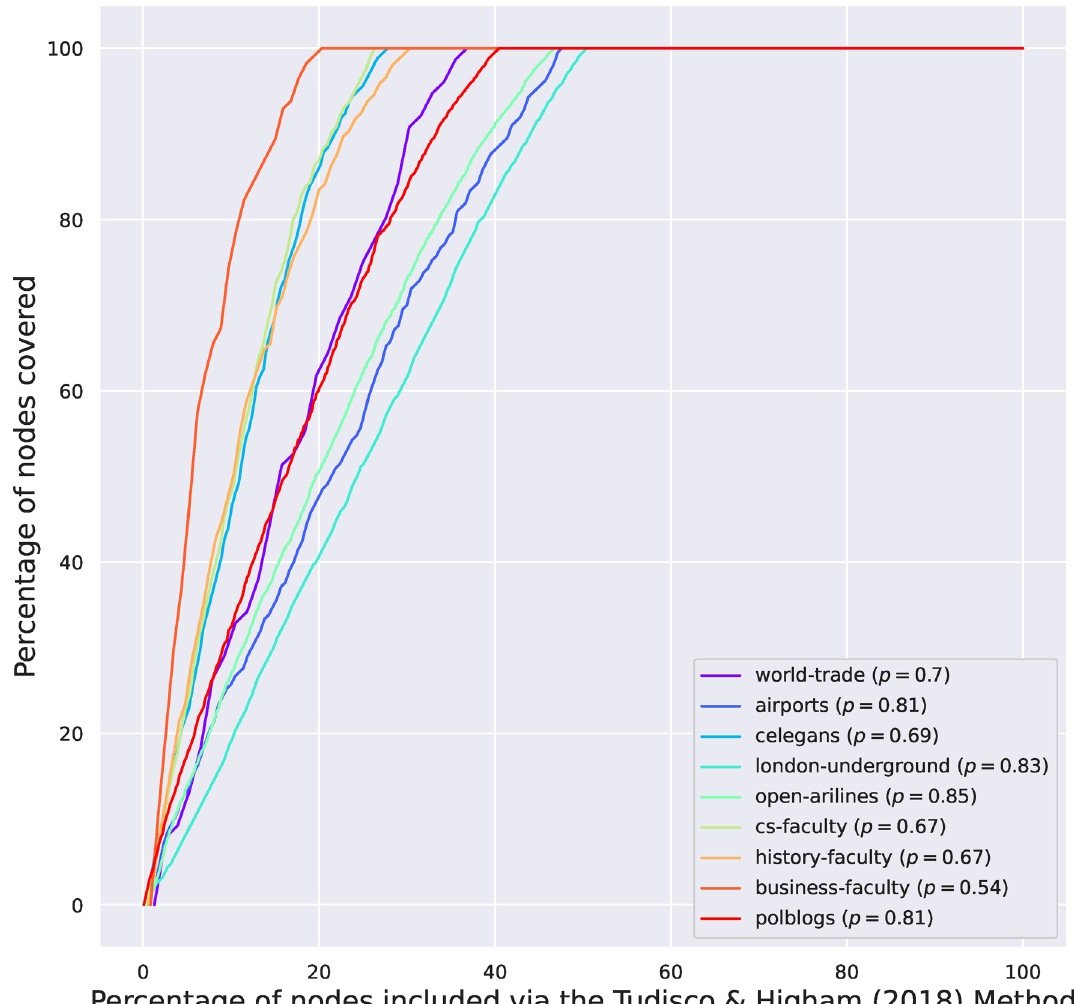
Figure 4. Domination Curve by running the method of Tudisco and Higham 19 . Source code to reproduce the Figure can be found in Ref. 33